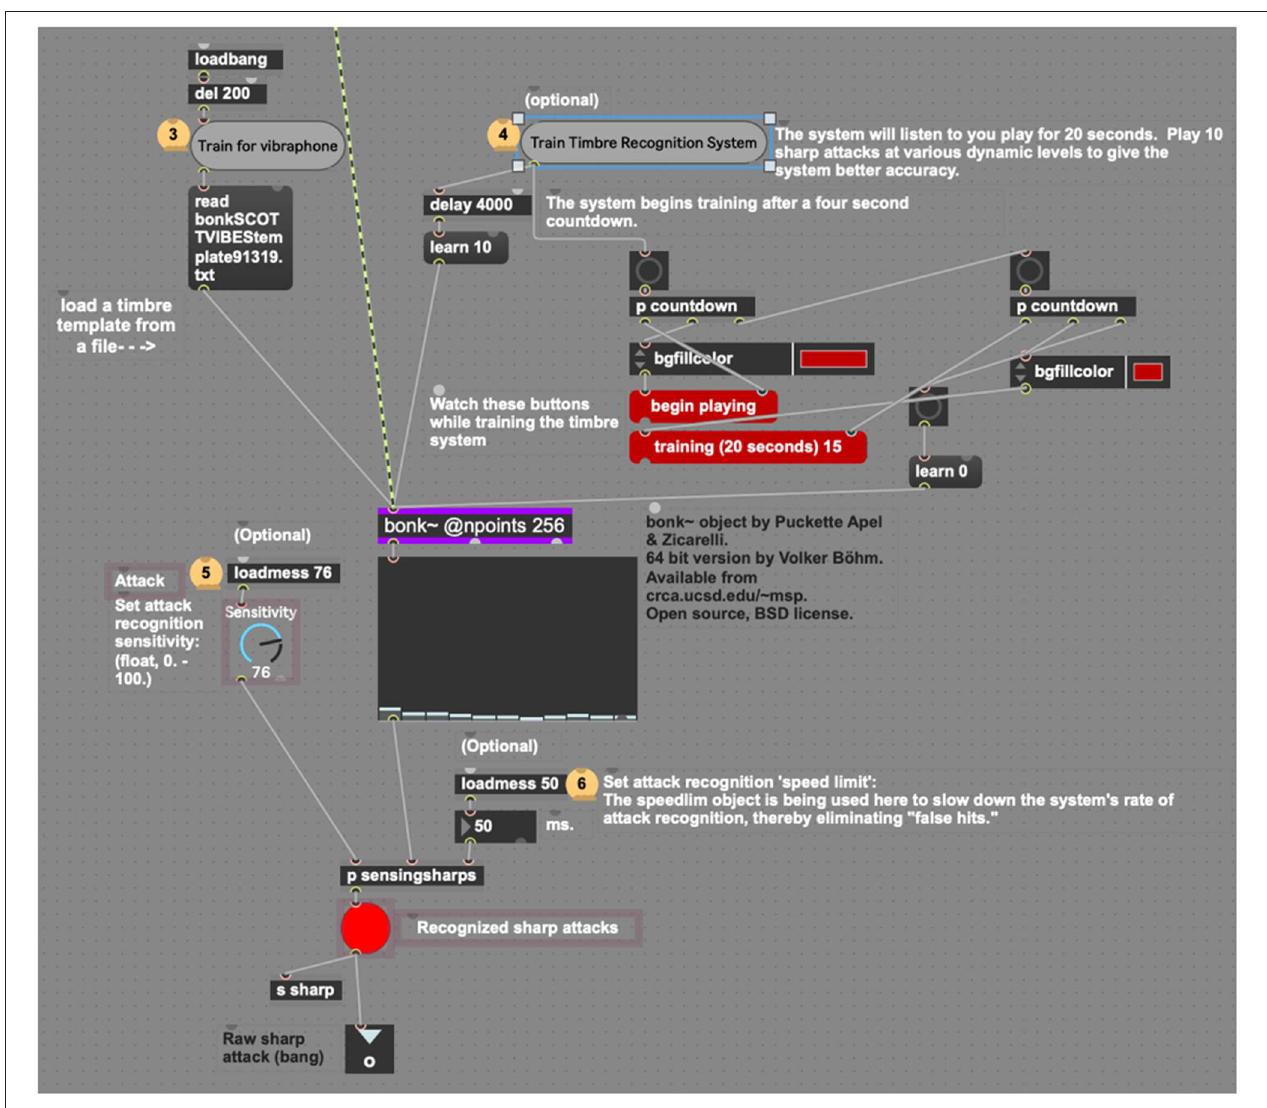
FIGURE 8 | The timbre recognition system, using bonk ∼